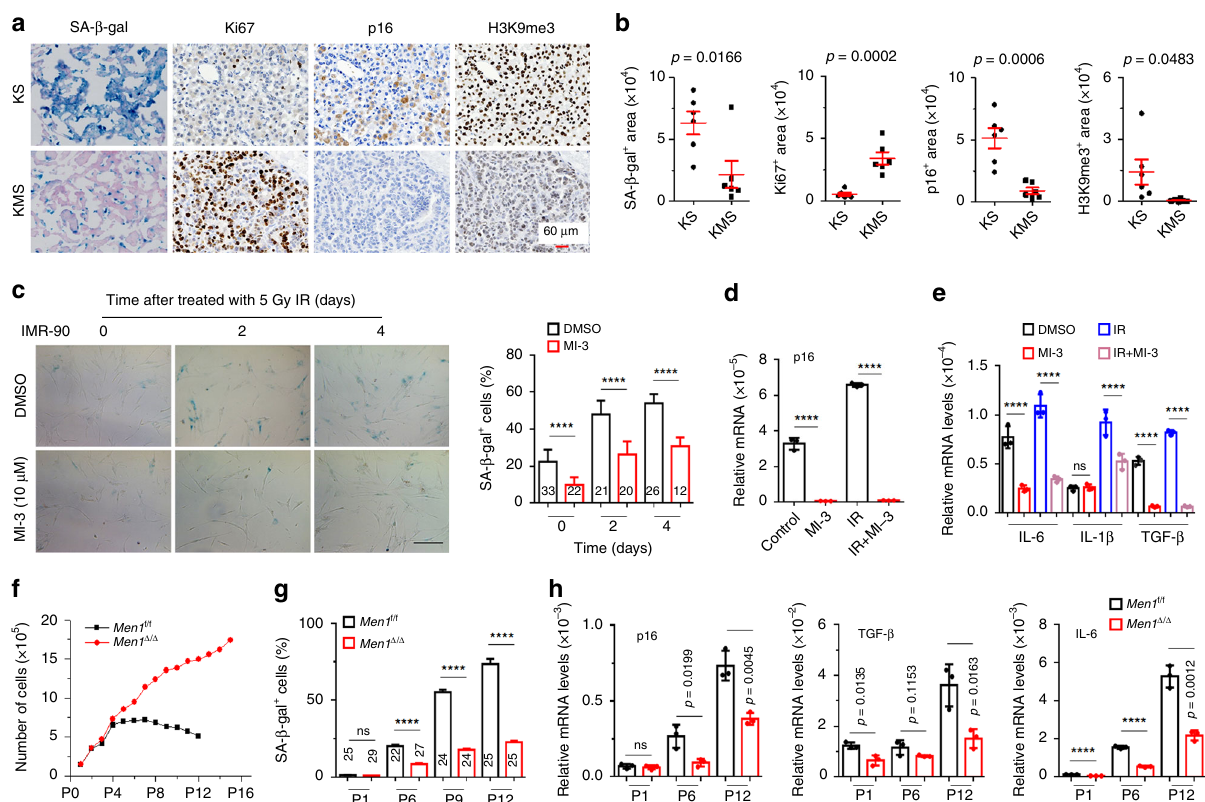
Fig. 5 Menin is required for the Kras -induced OIS programs. a Representative images of SA- β -gal staining and IHC staining of Ki67, p16, and H3K9me3 in lung consecutive sections from 11 weeks KS or KMS mice. Scale bars, 60 μ m. b Quanti fi cation of SA- β -gal staining, Ki67, p16, and H3K9me3 staining in a , n = 6 per group. c Images of SA- β -gal staining and quanti fi cation of SA- β -gal-positive cells. The cells were treated with 10 μ M MI-3 for 2 days before receiving 5 Gy of IR, and SA- β -gal staining was performed at the indicated time points after IR exposure. Scale bars, 100 μ m. d , e IMR-90 cells were treated with 10 μ M MI-3 for 2 days before IR and were collected 2 days after exposure to 5 Gy of IR. RT-qPCR was used to detect the mRNA levels of p16 , IL-6 , IL-1 β , and TGF- β . f Growth curve of primary Men1 f/f and Men1 Δ / Δ MEF cells during serial passages. Isolation and culture of primary MEF cells were performed as described in the Methods. The cells were treated with 1 μ M TAM and seeded in 6 cm dishes every 3 days. n = 3 for Men1 f/f and Men1 Δ / Δ , respectively. g Quanti fi cation of the SA- β -gal-positive cells shown in Supplementary Fig. 6i. h The mRNA expression of p16 , TGF- β , and IL-6 was measured by RT-qPCR in primary Men1 f/f and Men1 Δ / Δ MEF cells at the indicated passages. Data are represented as mean ± SEM in b , g and as mean ± SD in c , d , e , and h . Dots in d depict individual samples and in d , e , and h depict no repeat. Signi fi cance determined by two-tailed unpaired t tests in b , c , d , e , g , and h are indicated. **** p < 0.0001. Results in c – g , and h are representative of three independent experiments. Source Data are provided as a Source Data fi